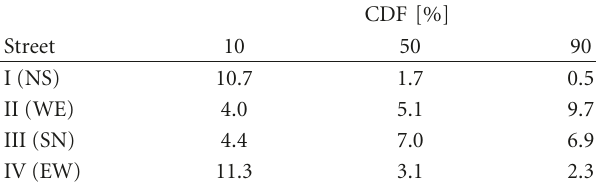
Table 6: Absolute errors of ergodic mutual information.